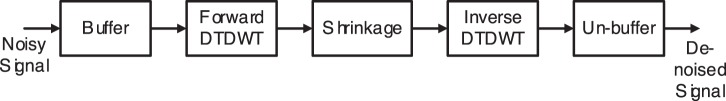
Block diagram of the dual-tree complex discrete wavelet transform (DTDWT) based noise reduction system.